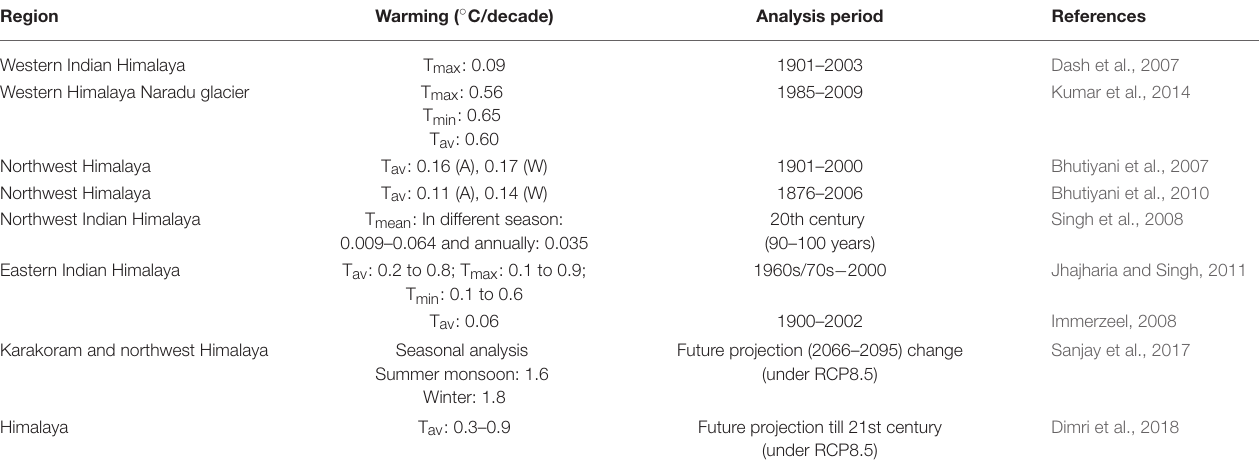
TABLE 1 | Summary of Temperature Trend Studies in IHR.